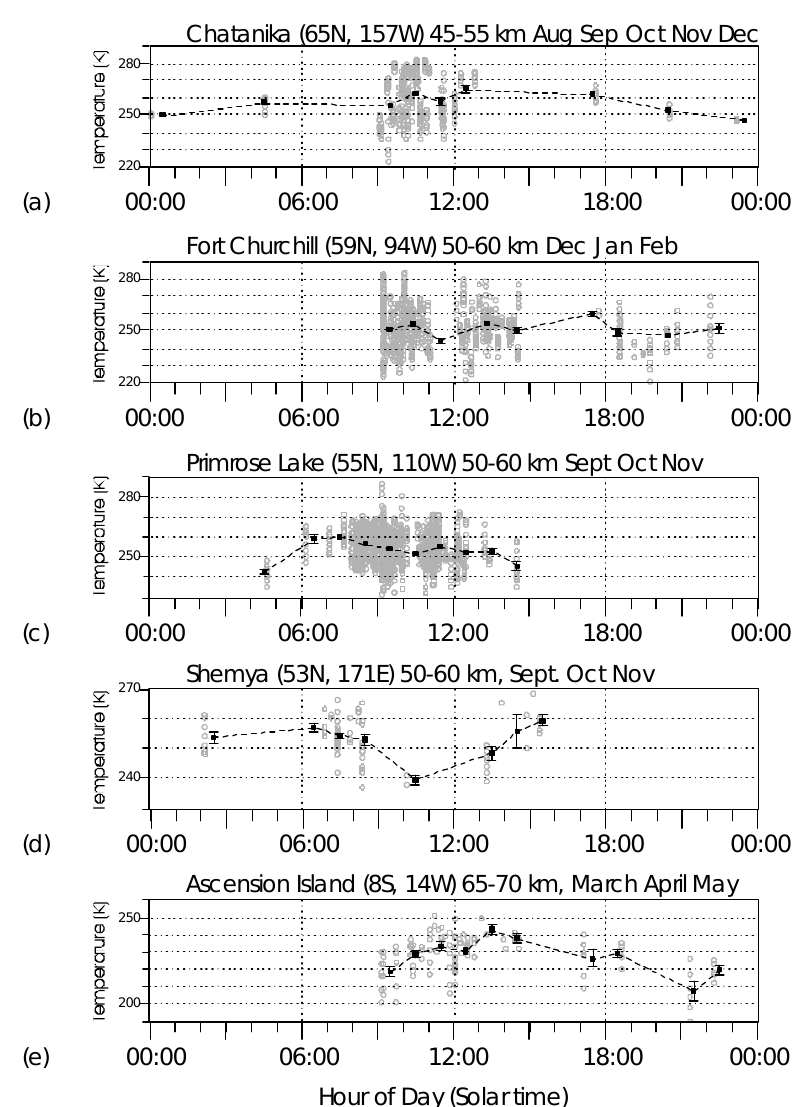
Fig. 13. Superposed epoch (composite day) graphs of rocket temperatures in the 40 to 70 km altitude range deduced at various rocket sites in the late 1970’s and early 1980’s. Light circles represent raw data, while dark squares represent hourly averages. Error bars illustrate the standard deviations for the means. Where no error bar is shown, it indicates that the error bars are smaller than the size of the square symbol used to represent the